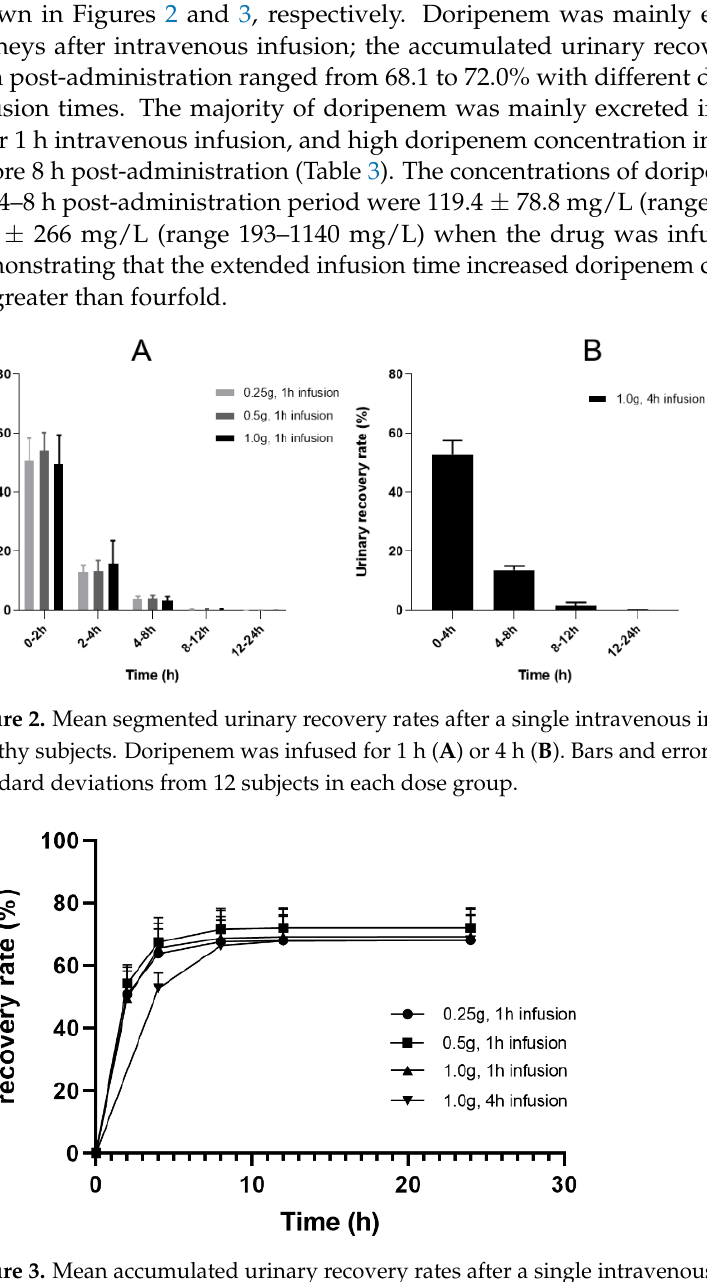
Figure 3. Mean accumulated urinary recovery rates after a single intravenous infusion of doripenem in healthy subjects. Symbols and error bars are the means and standard deviations from 12 subjects in each group. Table 3. Mean segmented doripenem concentration in urine of healthy Chinese subjects after a sin- gle intravenous infusion of doripenem (n = 12).